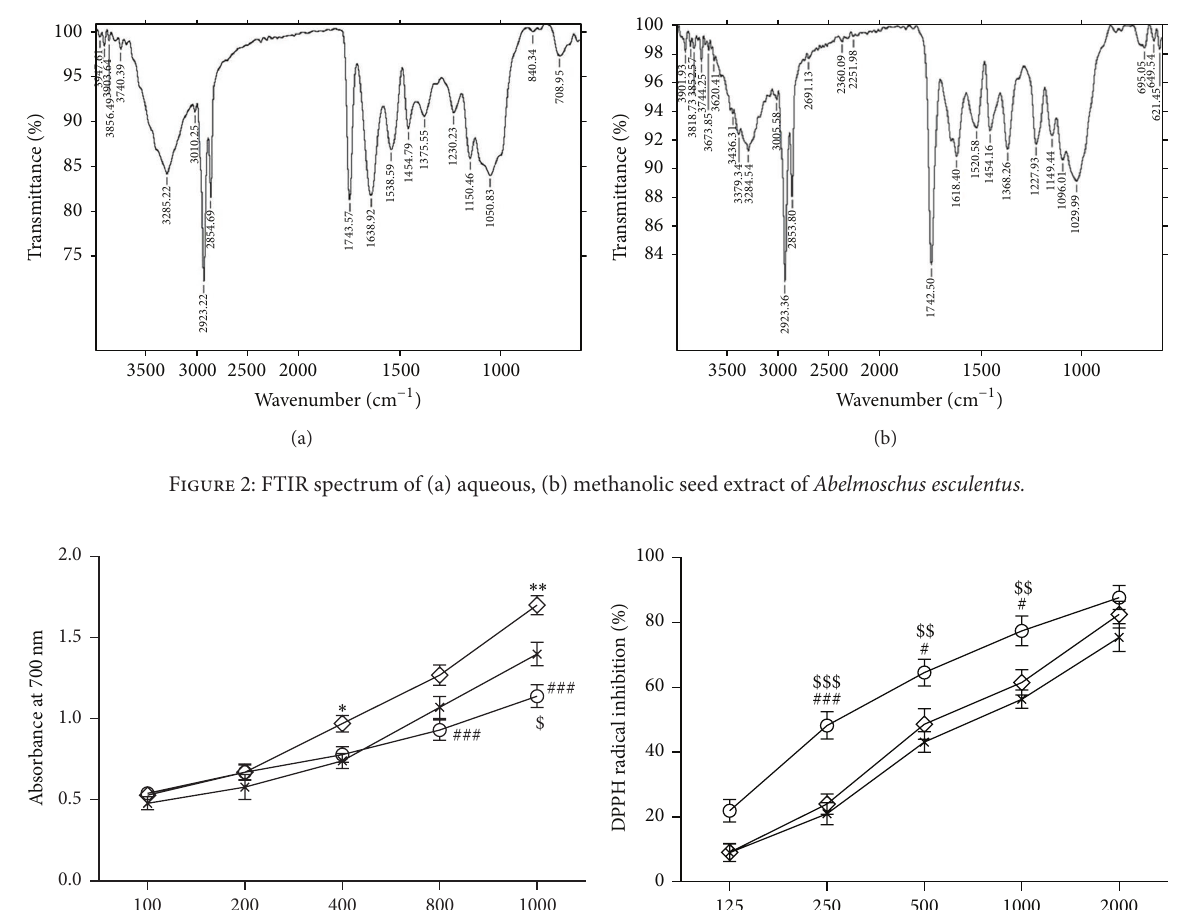
Figure 6. The shorter step-down latency of scopolamine was significantly reversed by pretreatment with reference drug, piracetam (223.2 ± 16.1 s). Similarly, AE (171.01 ± 18.6 s) and ME (182.12 ± 17.5 s) significantly reversed the scopolamine- induced memory impairment (Figure